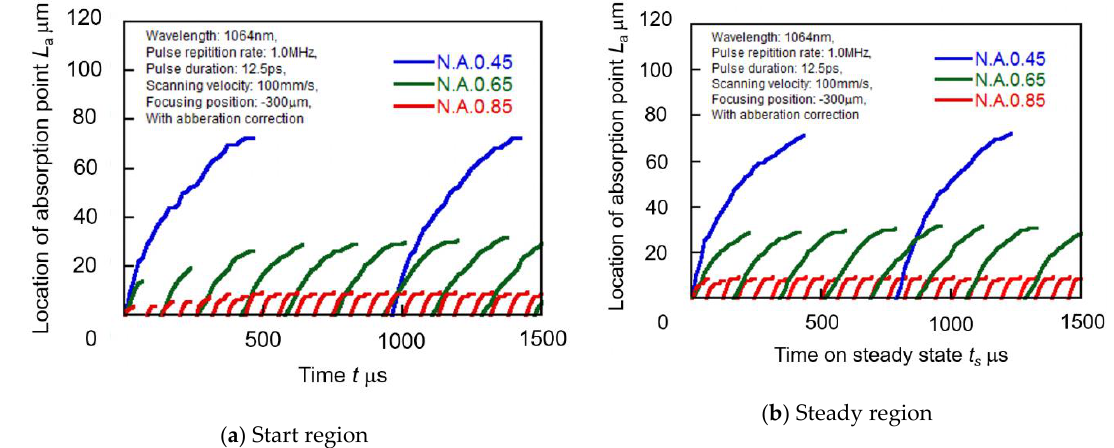
Figure 11. Influence of numerical aperture on absorption point movement.